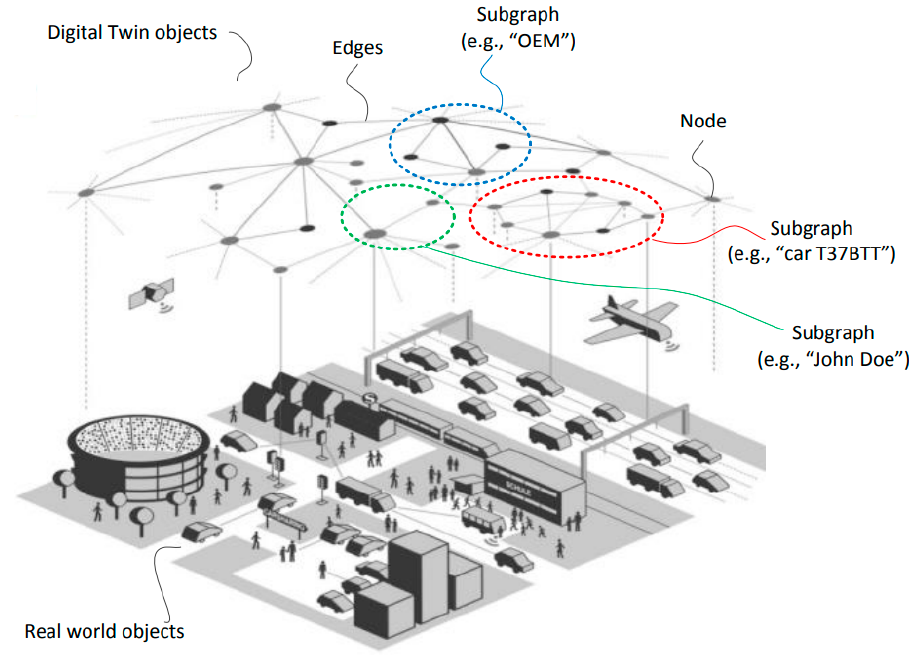
Figure 2. IoT Lifecycle via Digital Twins, adopted from [8].